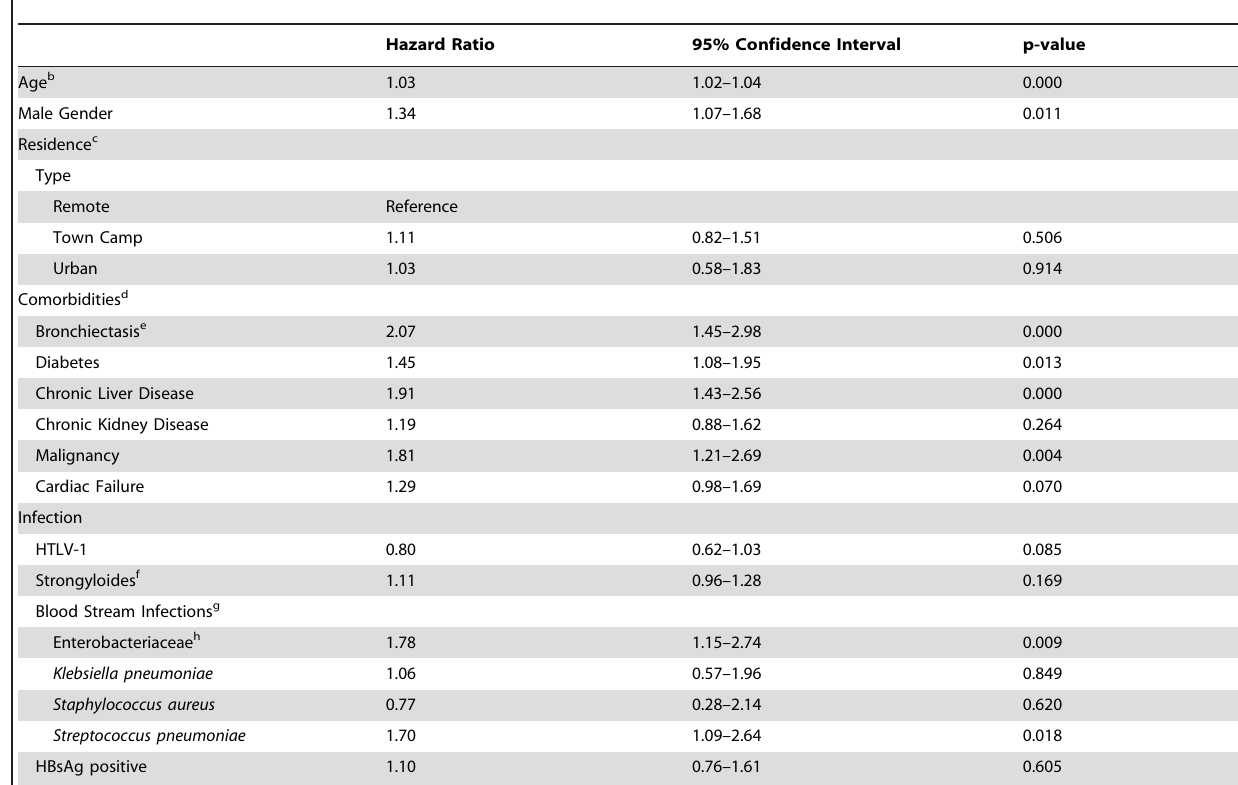
Table 7. Adjusted Cox proportional hazards modeling of predictors of death a